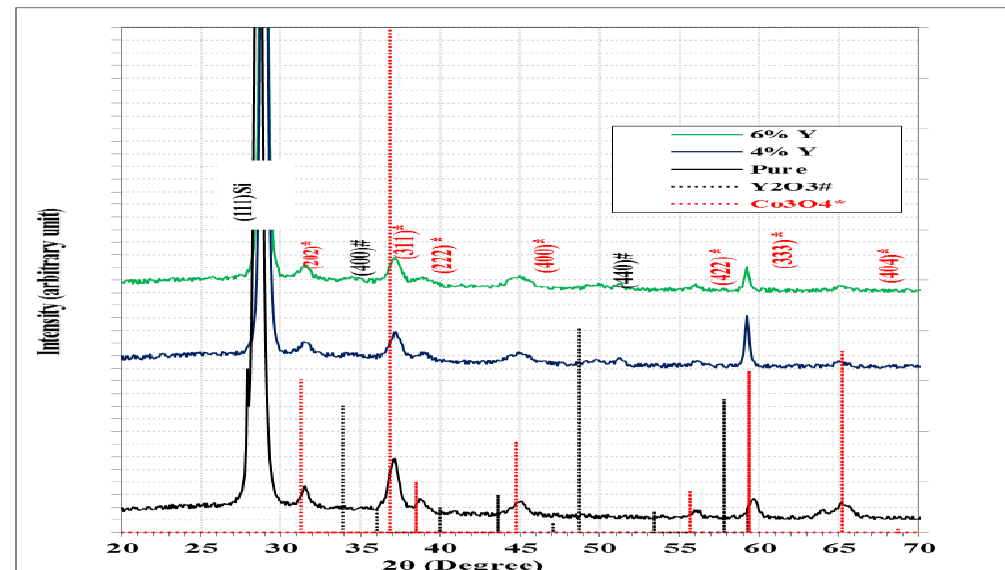
Fig. 1: XRD patterns of cobalt oxide and cobalt yttrium oxide grown onto Si p-type substrates Table 1: Structure Parameters for Co